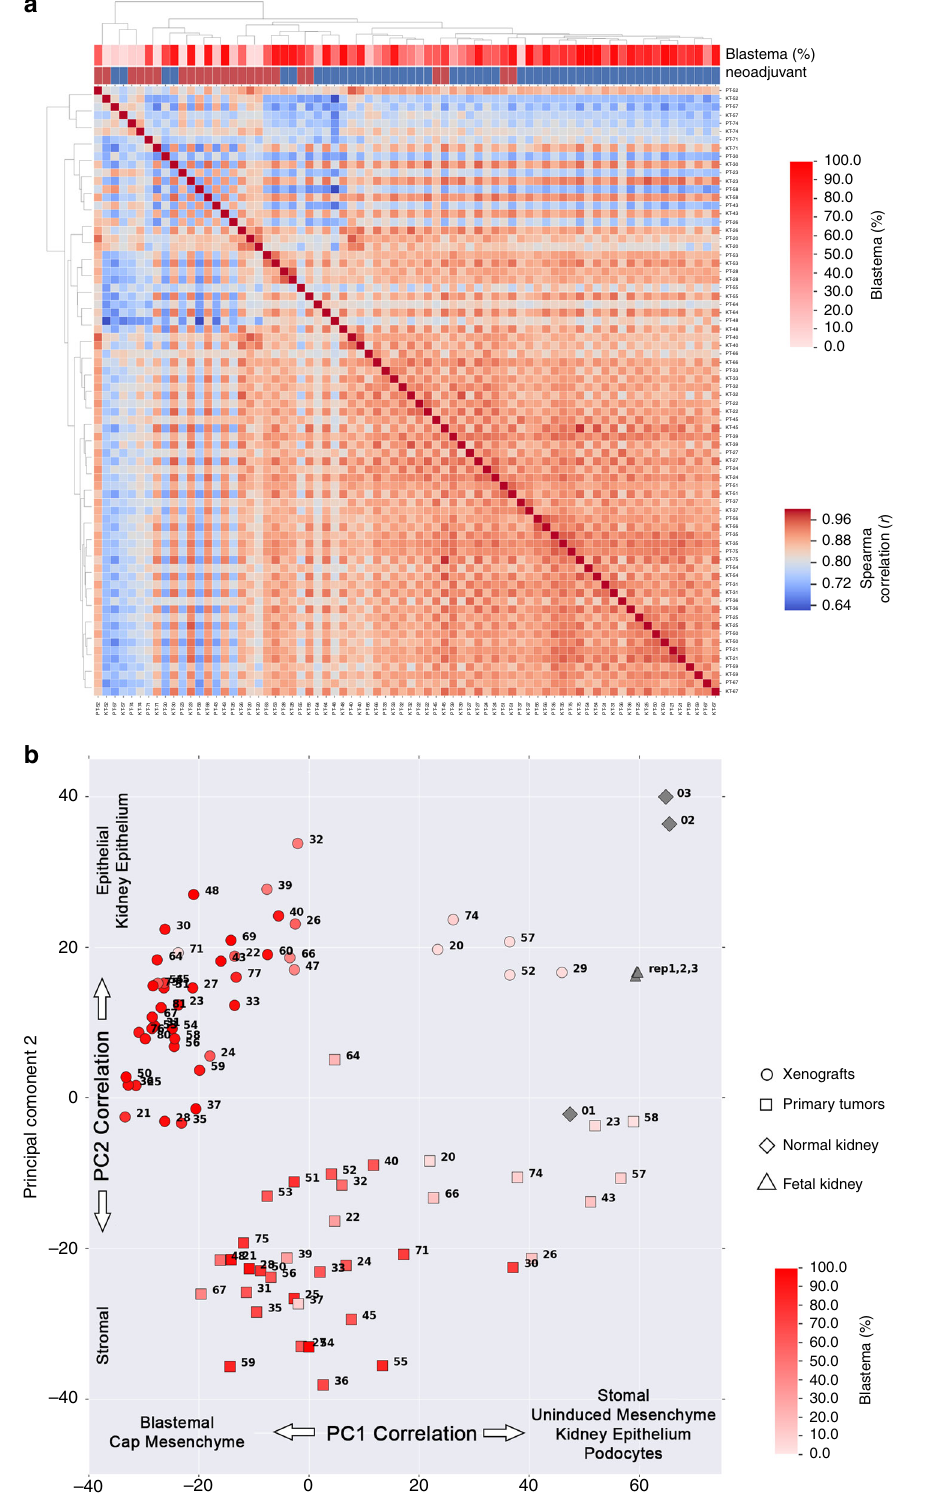
Discussion Herein, we established an annotated library of 45 heterotopic patient-derived xenografts that captures the clinical and biological heterogeneity of WT. Our diverse panel of WTPDX includes comprehensively annotated in vivo models of